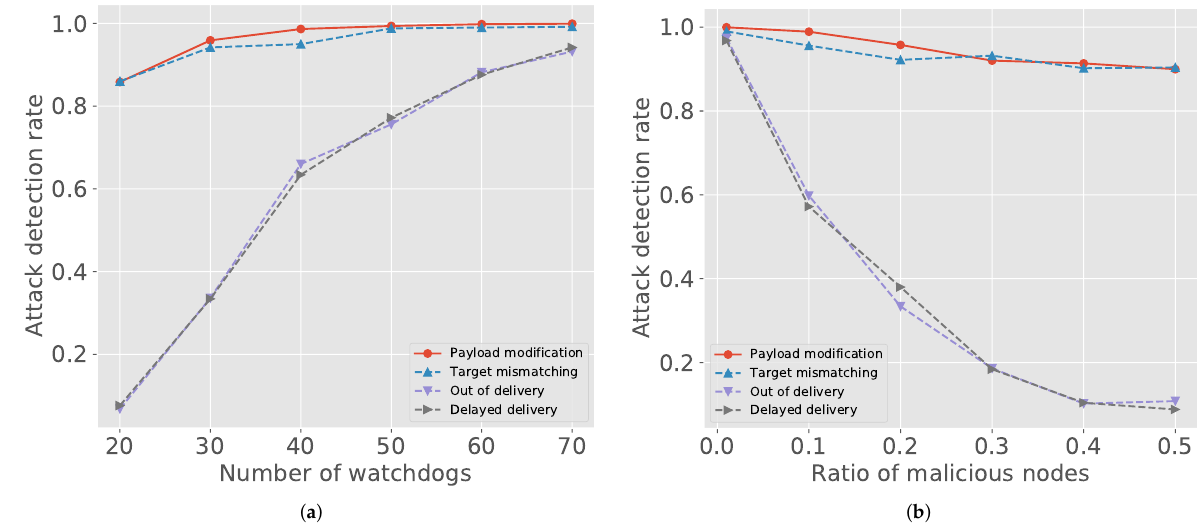
Figure 2. Attack and malicious node detection rate: ( a ) number of watchdogs vs. attack detection rate; and ( b ) number of malicious nodes vs. attack detection